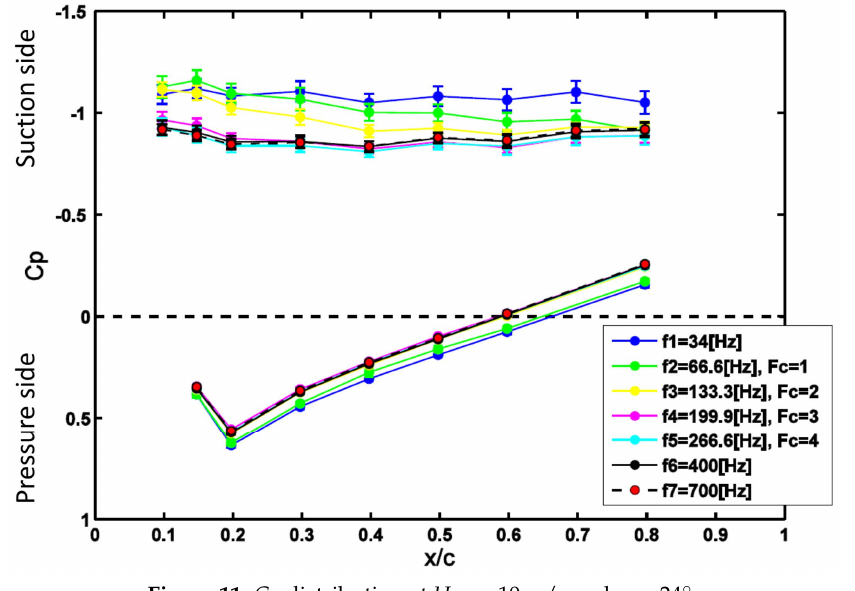
Figure 11. C p distribution at U ∞ = 10m/s and α = 24 ◦ .